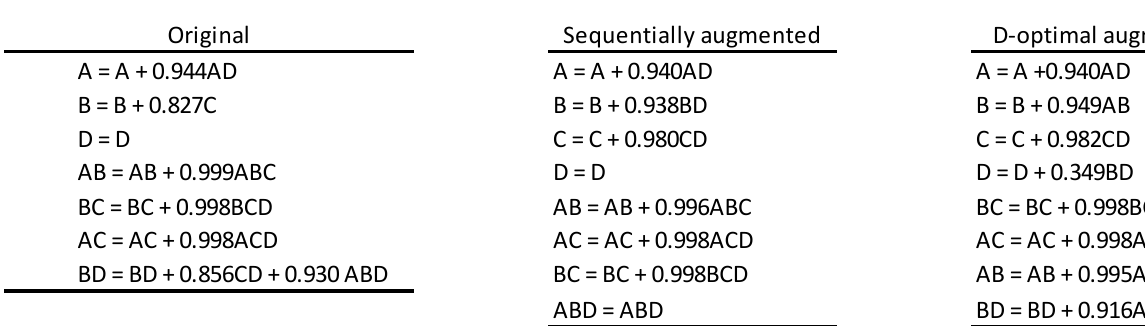
Figure 17. Original, sequentially augmented, and D-optimal augmented designs.